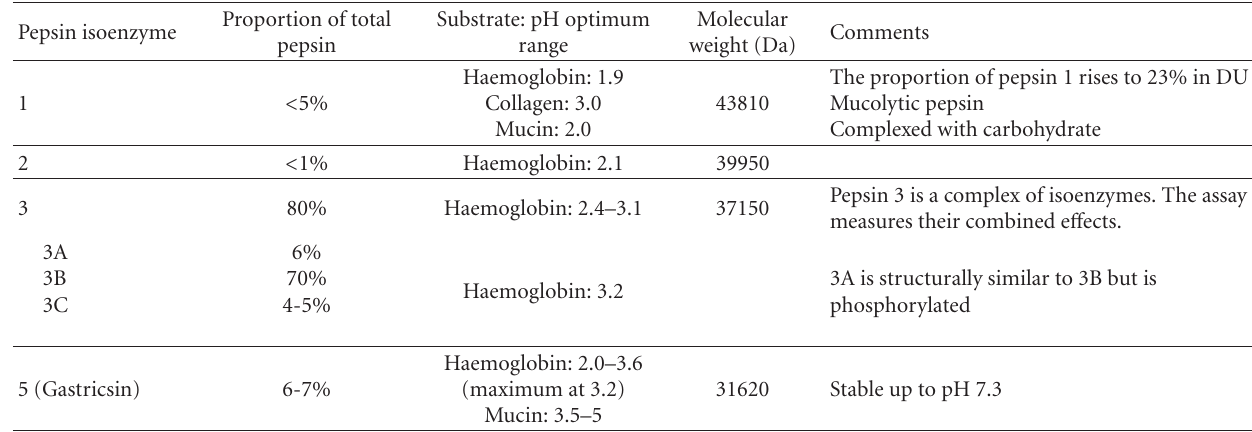
Figure 1: Example of pepsin profile from human gastric juice purified by HPAEC. Table 1: The active pepsin isoenzymes in